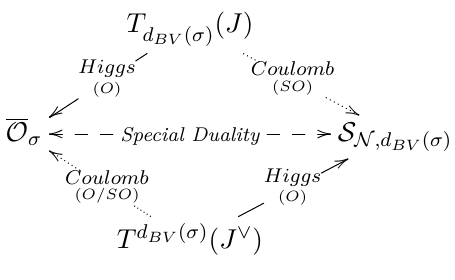
Figure 2. BV Duality of Special BCD Orbits. The closure O σ of a special nilpotent orbit of J is dual under the Barbasch Vogan map to a Slodowy slice S T ( J ) and T d BV ( σ ) ( J ∨ ) are related by 3 d-mirror duality. For a fuller explanation see d BV ( σ )